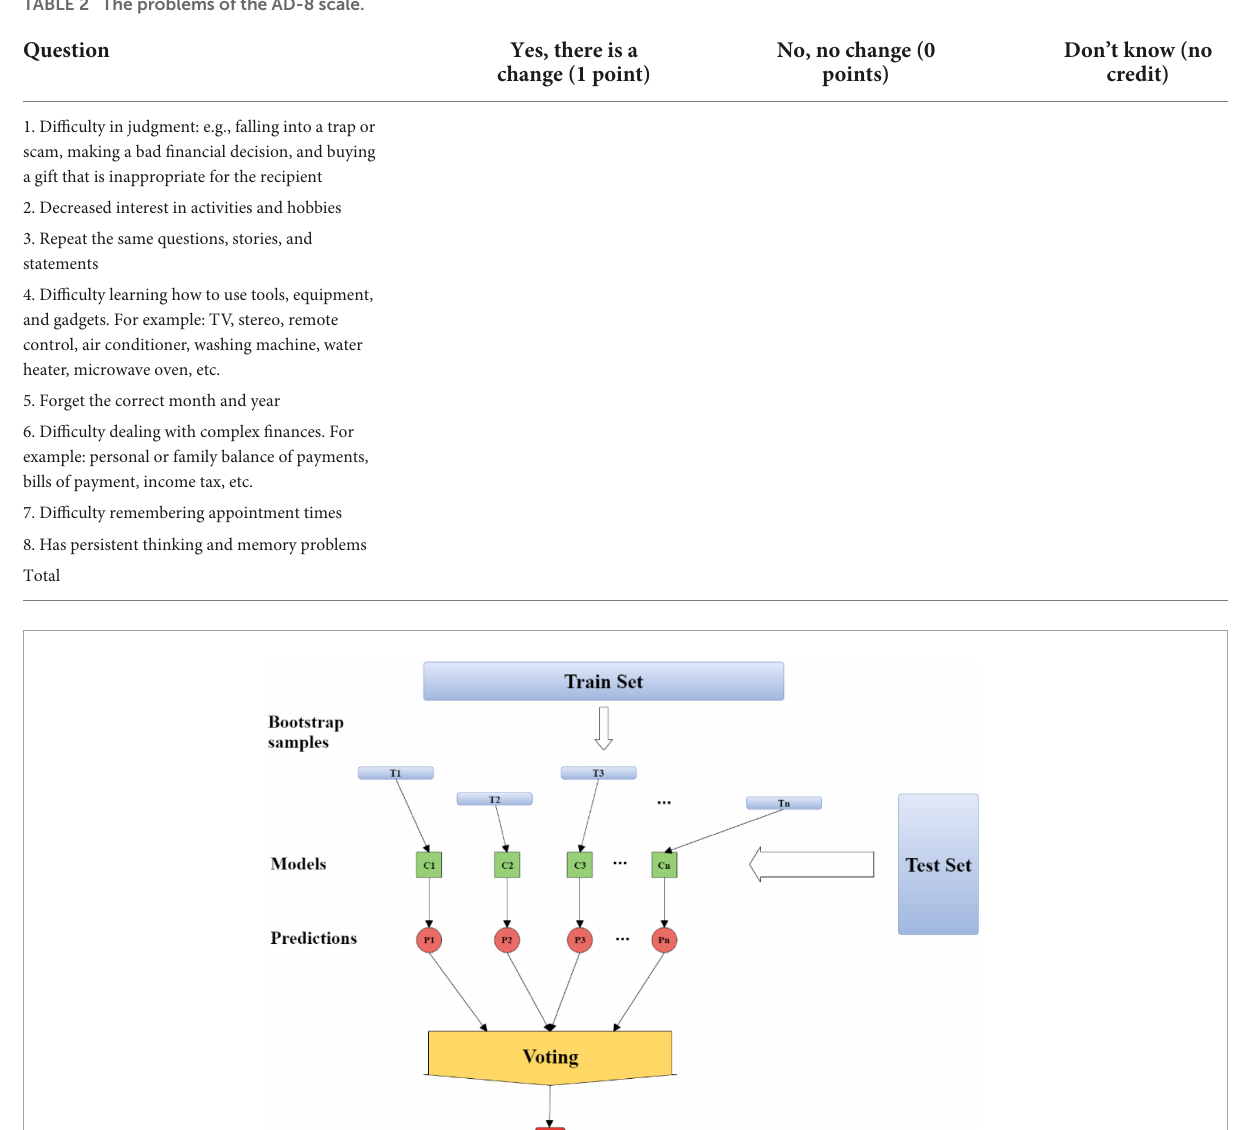
FIGURE1 The process of Bagging algorithm.